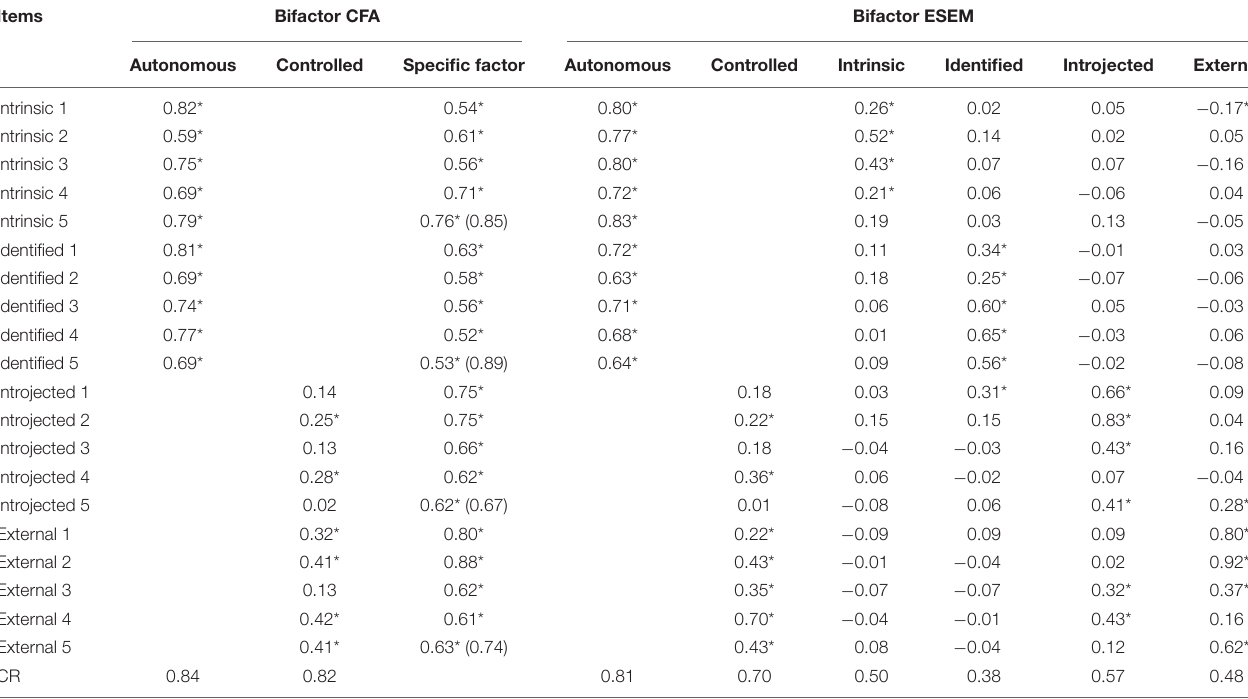
TABLE 2 | Bifactor CFA and bifactor ESEM factor loadings of the SDT-L2 scale. Items Bifactor CFA Bifactor ESEM